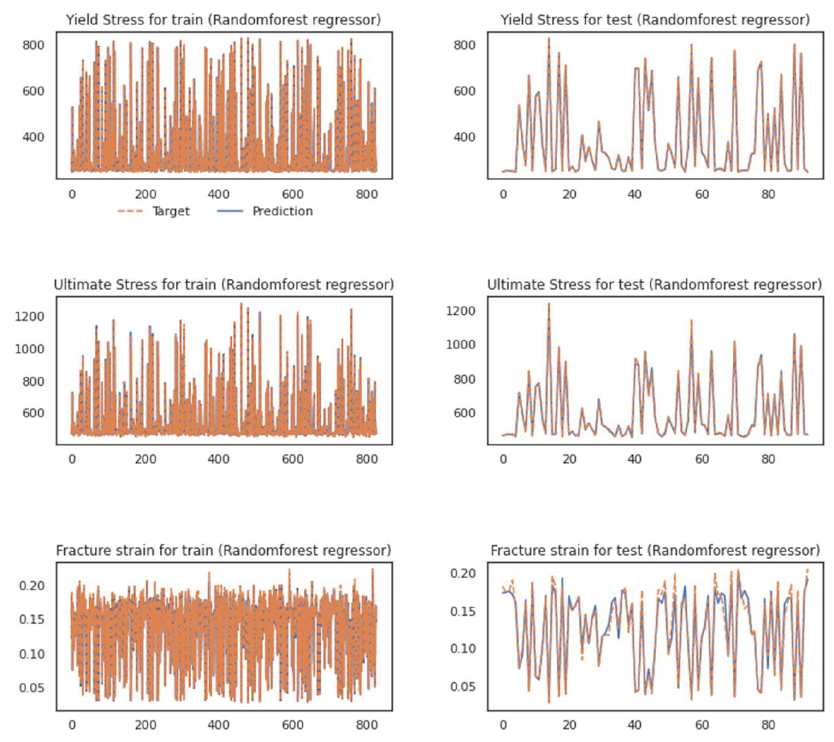
Figure 9. Performance of the proposed hybrid model while using the RF regressor for the training set (left diagrams) and test set (right figures).